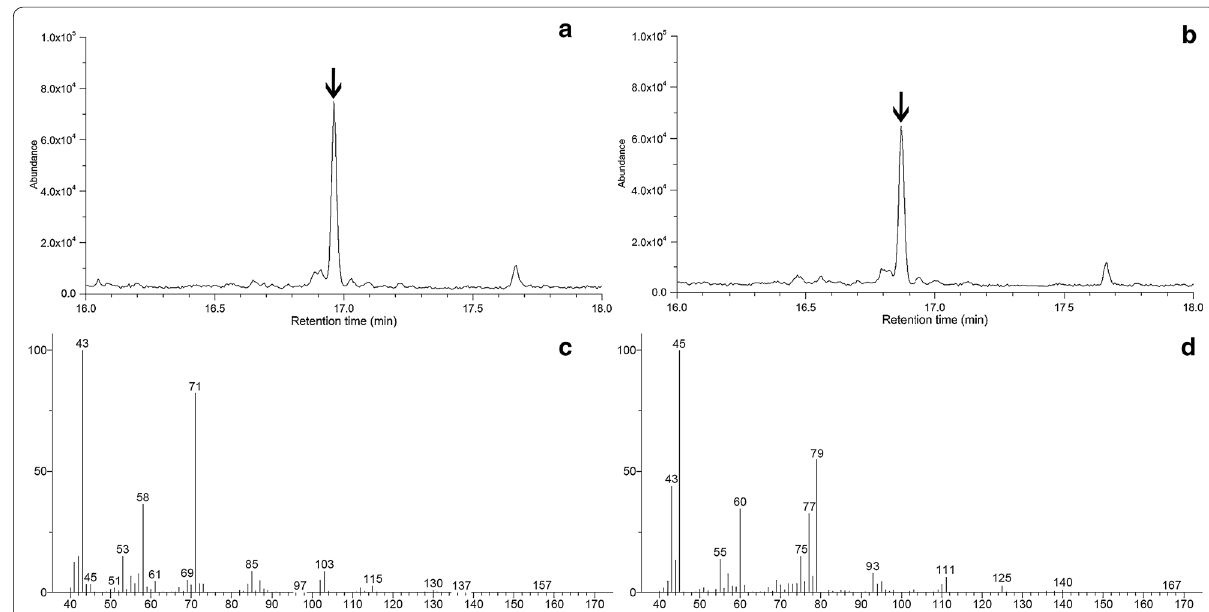
Fig. 5 Identification of mevalonic acid lactones by GC–MS. Total ion chromatograms of mevalonic acid lactones produced from ethanol ( a ) and ethanol-D6 ( b ) (the peaks of mevalonic acid lactones were indicated with arrows); mass spectra of mevalonic acid lactones produced from ethanol ( c ) and ethanol-D6 ( d